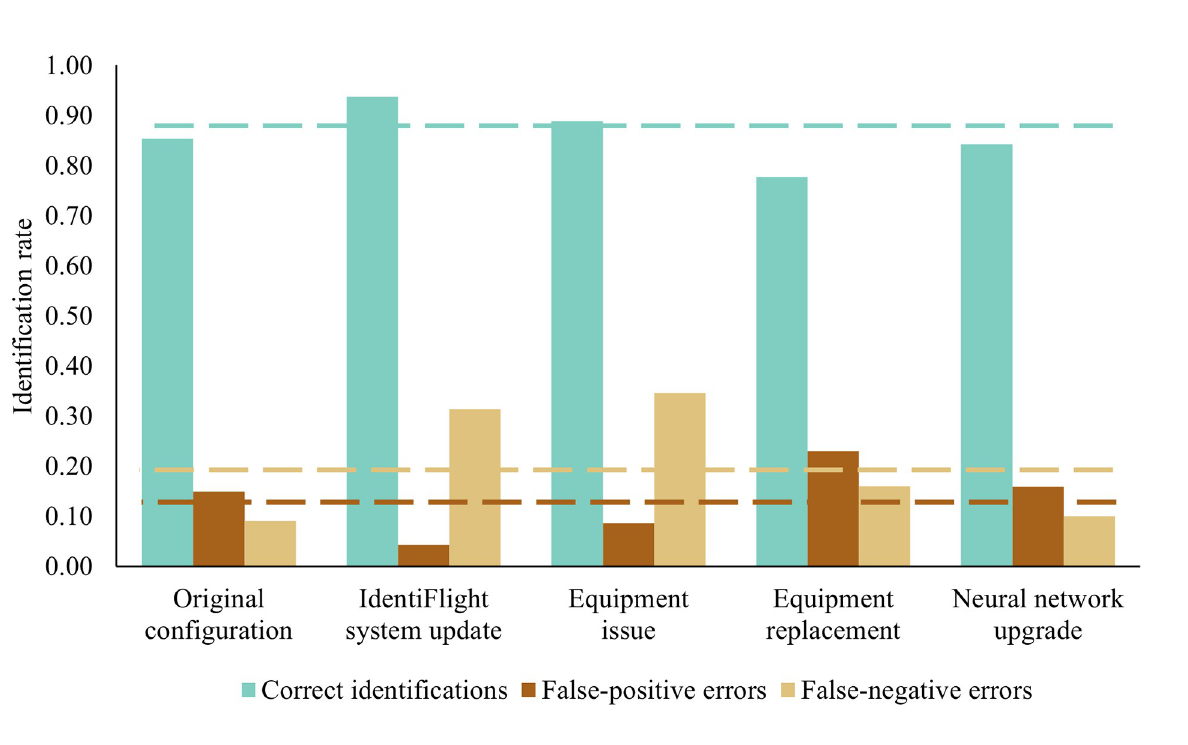
Fig 3. Correct and incorrect identification rates by the IdentiFlight system during each of the five time periods over which the system changed (see Table 1 and S2 File). Average rates are shown by dashed lines. Each rate is based on a different subset of the data; correct identifications apply to all records, false-negative errors apply only to eagles and false-positive errors apply only to non-eagles, as determined by raptor